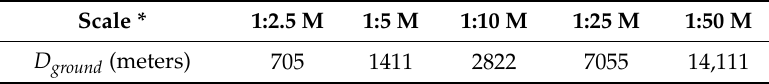
Table 1. The distances corresponding to minimum resolvable